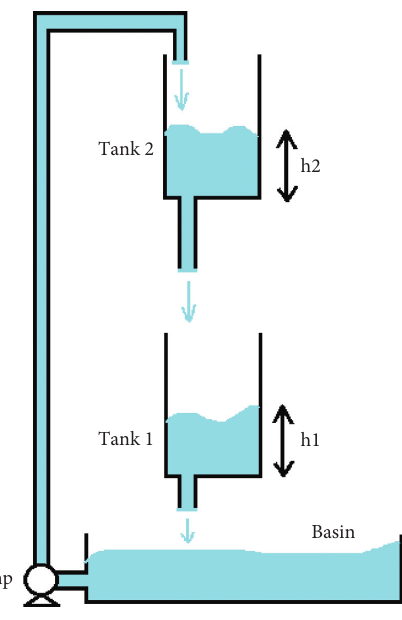
Figure 1: State-coupled two-tank